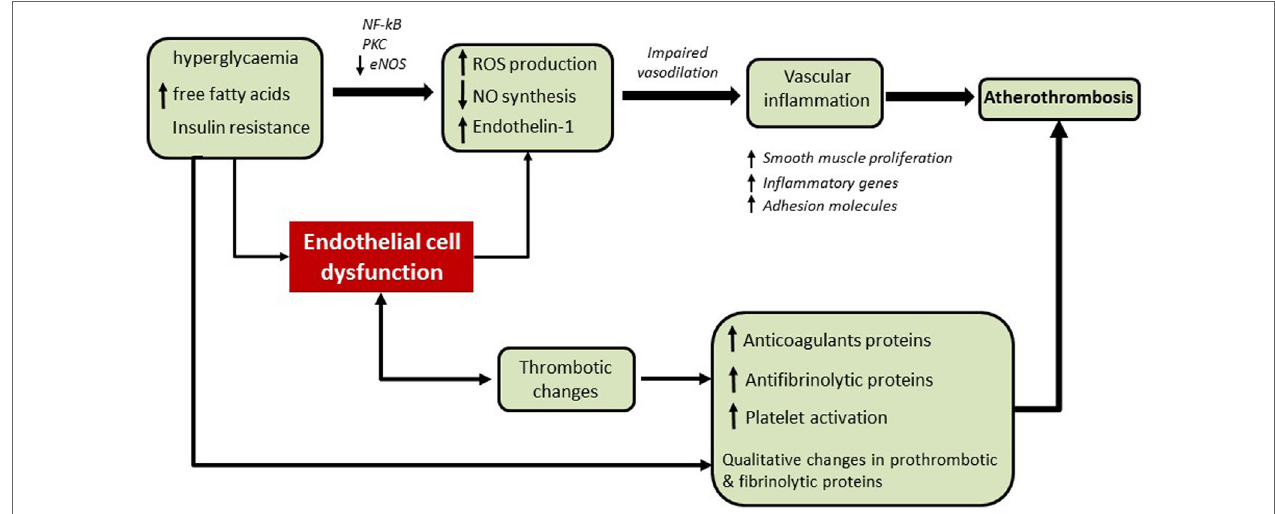
FigURe 1 | The accelerated vascular pathology and enhanced thrombotic environment in diabetes. Endothelial dysfunction plays a key role in all stages of the atherosclerotic process. In the early stages of the disease, insulin resistance and increased levels of glucose and free fatty acids enhance the production of reactive oxygen species (ROS) and reduce nitric oxide (NO) synthesis via several mechanisms including activation of NF- κ B and protein kinase C (PKC) signaling and reduction of endothelial NO synthase (eNOS) activity. Endothelial dysfunction contributes to the impairment of vasodilation, expression of adhesion molecules, and further vascular inflammation. In the latter stages of the disease, endothelial dysfunction results in increased platelet activation and a prothrombotic/hypofibrinolytic environment which facilitates vascular occlusion and